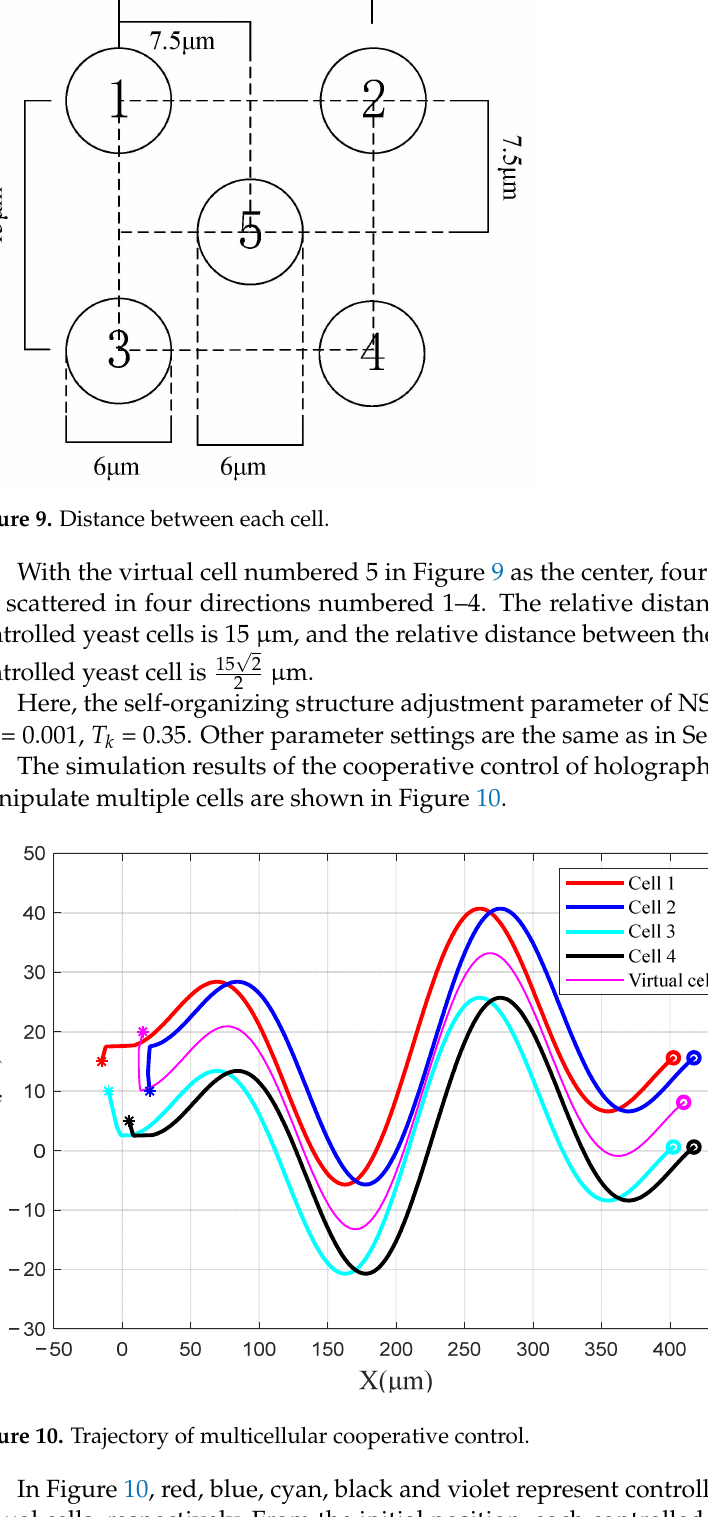
Figure 10. Trajectory of multicellular cooperative control. In Figure 10, red, blue, cyan, black and violet represent controlled yeast cells 1–4 and virtual cells, respectively. From the initial position, each controlled yeast cell can